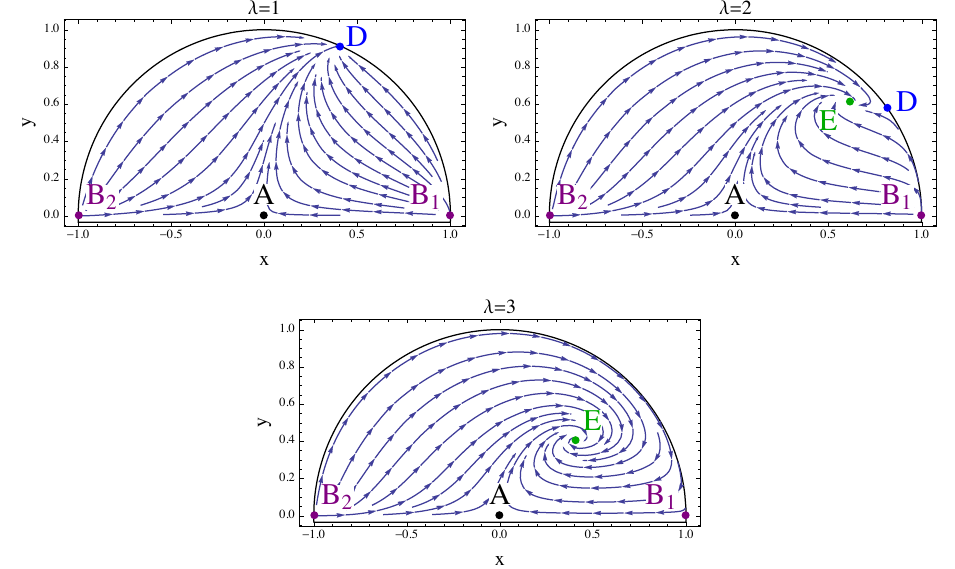
Figure 1. Phase planes for three qualitatively different cases of λ and w